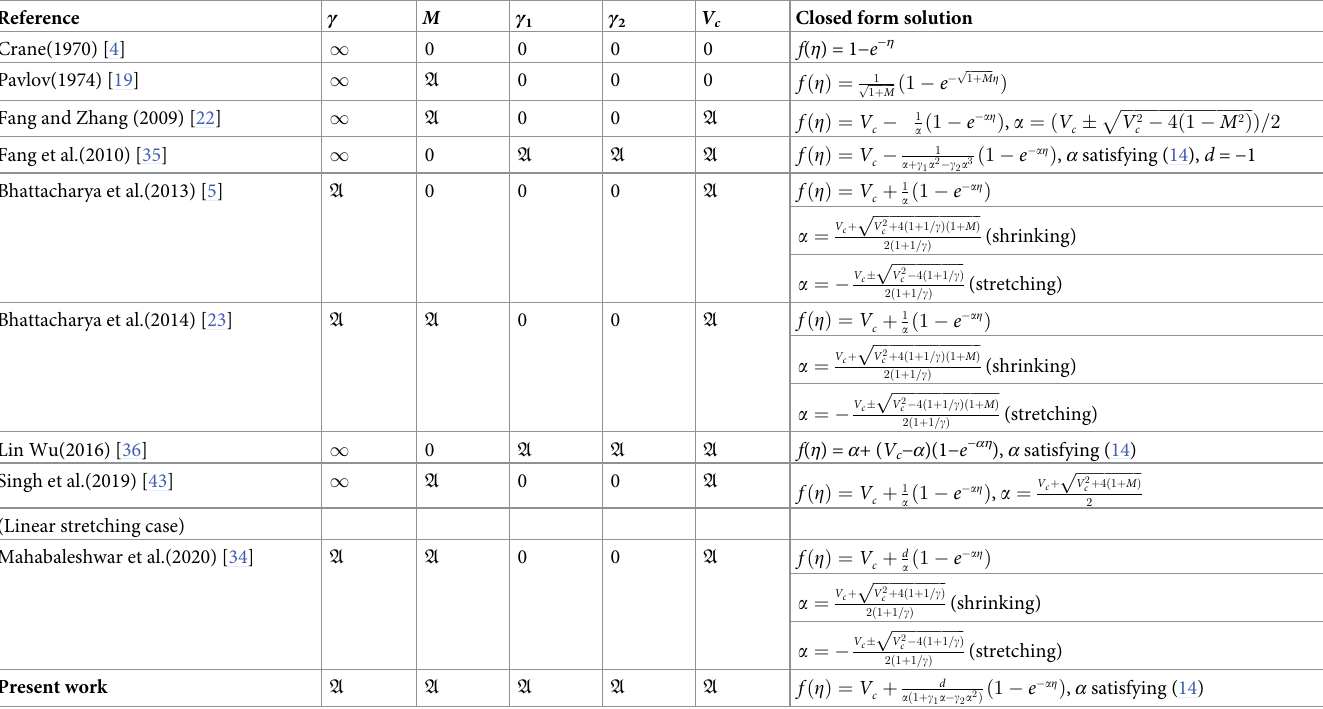
Table 1. Solutions deductible from present formulation. The symbol A refers to as any permissible value of the corresponding parameter.